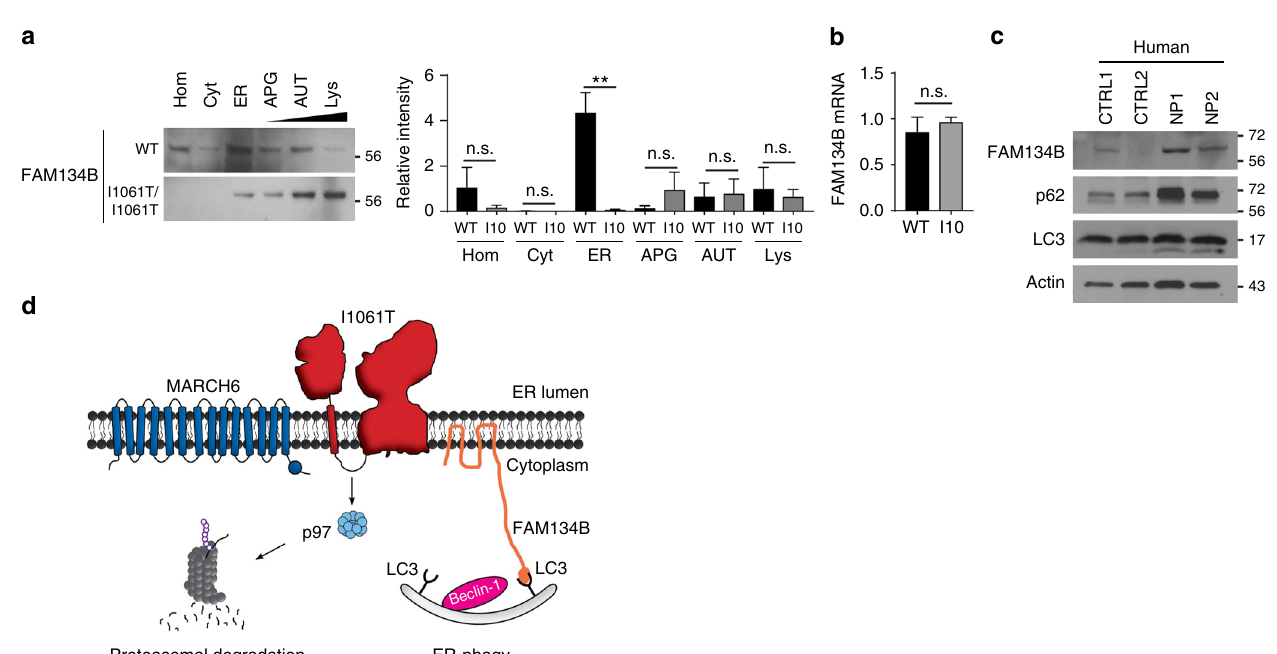
Fig. 8 Flux through ER-phagy is altered in Niemann – Pick C mouse and patient brain. a Whole brain homogenates (Hom) from 7-week-old WT and I1061T-